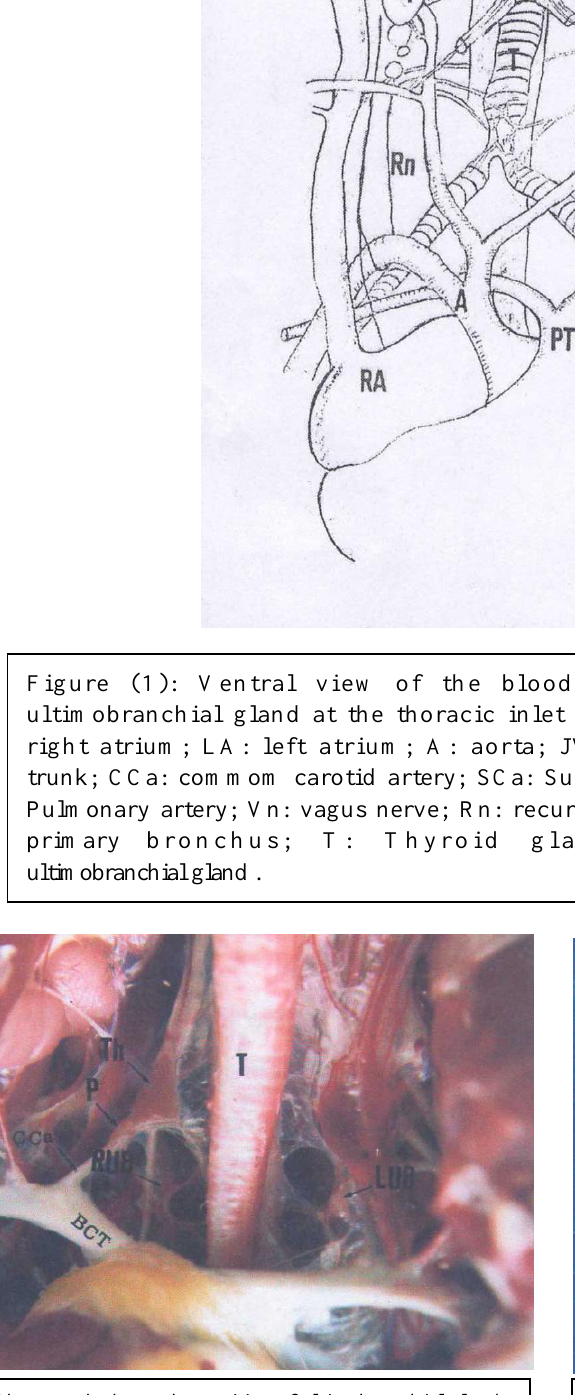
(Fig.2) Photograph show the shape and size of ultimobronchial in young gees. Left (LUB) and right (RUB). Insert show the left (LUB) and right (RUB) in adult geese.